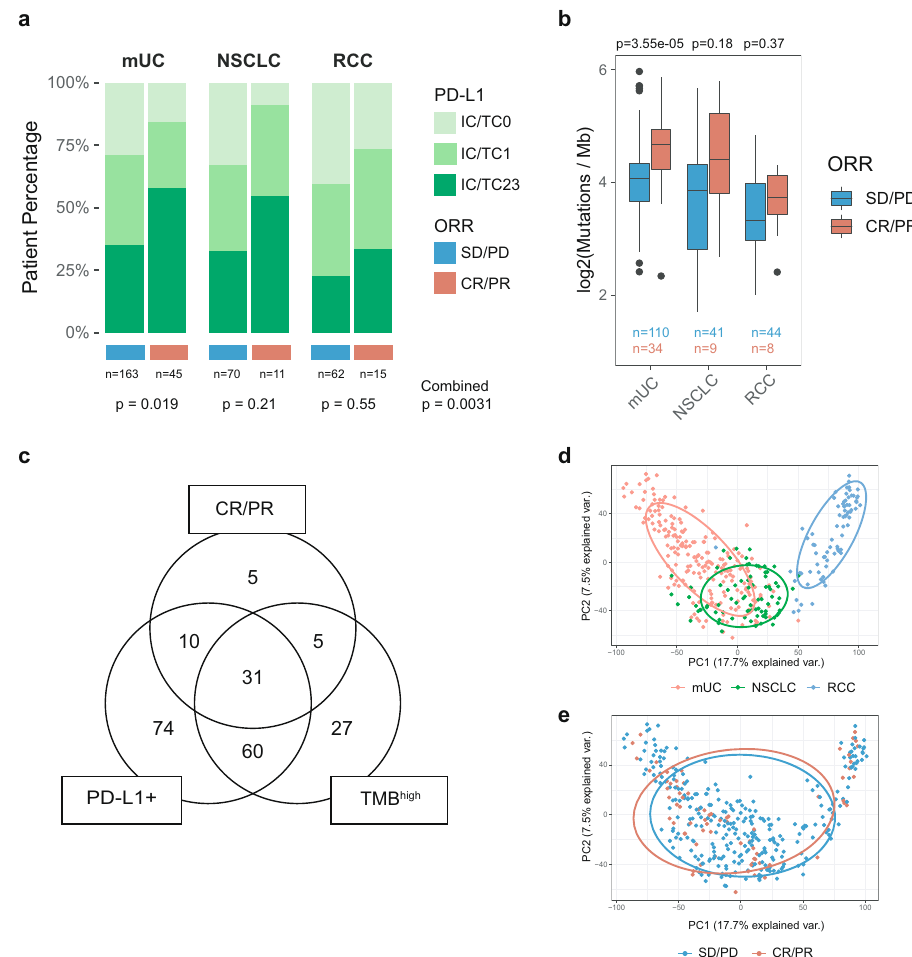
Fig. 1 PD-L1, TMB, and global RNA-seq pro fi les in mUC, NSCLC, and RCC cohorts. a Bar chart representing the distribution of PD-L1 expression on TC and IC by indication and response group. PD-L1 distribution between response groups within and across indications was statistically tested using the two- sided Pearson ’ s chi-squared test. b Boxplot representing TMB by indication and response group. TMB differences within each indication were tested using the non-corrected two-sided Wilcoxon rank-sum test. The center of the boxplot represents the median. The lower and upper hinges correspond to the fi rst and third quartiles. The upper whisker extends from the hinge to the largest value no further than 1.5 × IQR (interquartile range) from the hinge. The lower whisker extends from the hinge to the smallest value at most 1.5 × IQR of the hinge. c Venn diagram representing the overlap between responders, PD-L1 + patients and TMB high patients. d Two-dimensional scatter plot representing sample distribution according to the fi rst two components obtained from principal component analysis (PCA) of the complete RNA-seq-evaluable dataset ( n = 366) based on the 16,581 genes used for analysis. Dots are colored by indication and ellipses capture all samples within one standard deviation of the mean per normal probability statistics (68%). e Same as d , colored by response